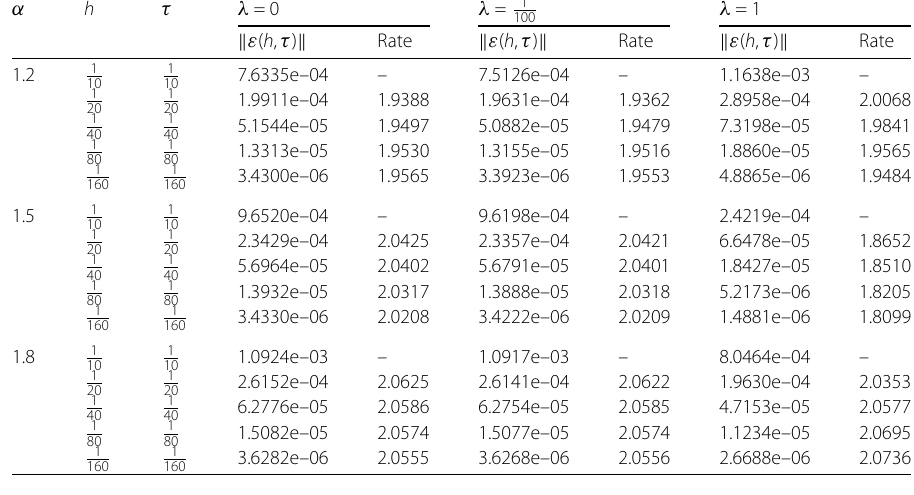
Table 1 Errors and corresponding observation orders of T-ML 2 in spatial and temporal directions for Example 1 with different α and λ